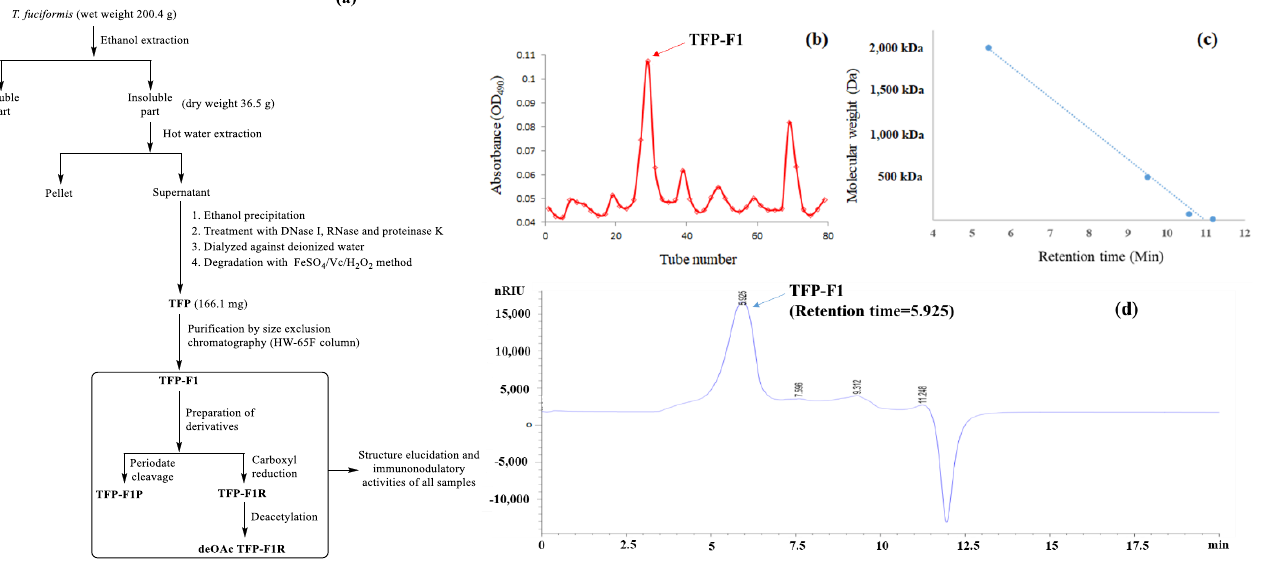
Figure 1. ( a ) A flow chart showing the procedures used to purify polysaccharides from T. fuciformis and evaluate their immunomodulatory activity ( b ) Size-exclusion chromatography HW-65F profile of TFP-F1. Fractions containing carbohydrates were determined using the phenol–sulfuric acid method. TFP-F1 was collected from tubes 26 to 33. ( c ) Standard curves of the dextran samples in HPLC, including 2000 kDa, 500 kDa, 70 kDa, and 10 kDa, were run in a BioBasic SEC-1000 column. ( d ) MW analysis of TFP-F1 was followed by ( c ).